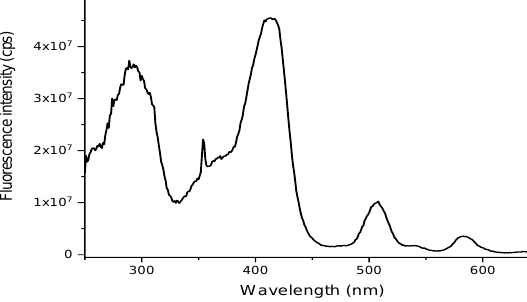
Figure 4. Excitation spectrum of dyad 1 in DCM at 710 nm. at 720 nm, but with a lower quantum yield (QY) of 0.03. Comparison with the generic tetrakis-pentafluorophenylporphyrin (2H-20F-TPP) shows an approximate 6% QY, while combined results show: (1) that the heptazine emission is totally quenched by transfer processes, and (2) that the decreased emission QY demonstrates that energy transfer is not the sole process since the very similar tris-(perfluorophenyl)-porphyrin alone displays